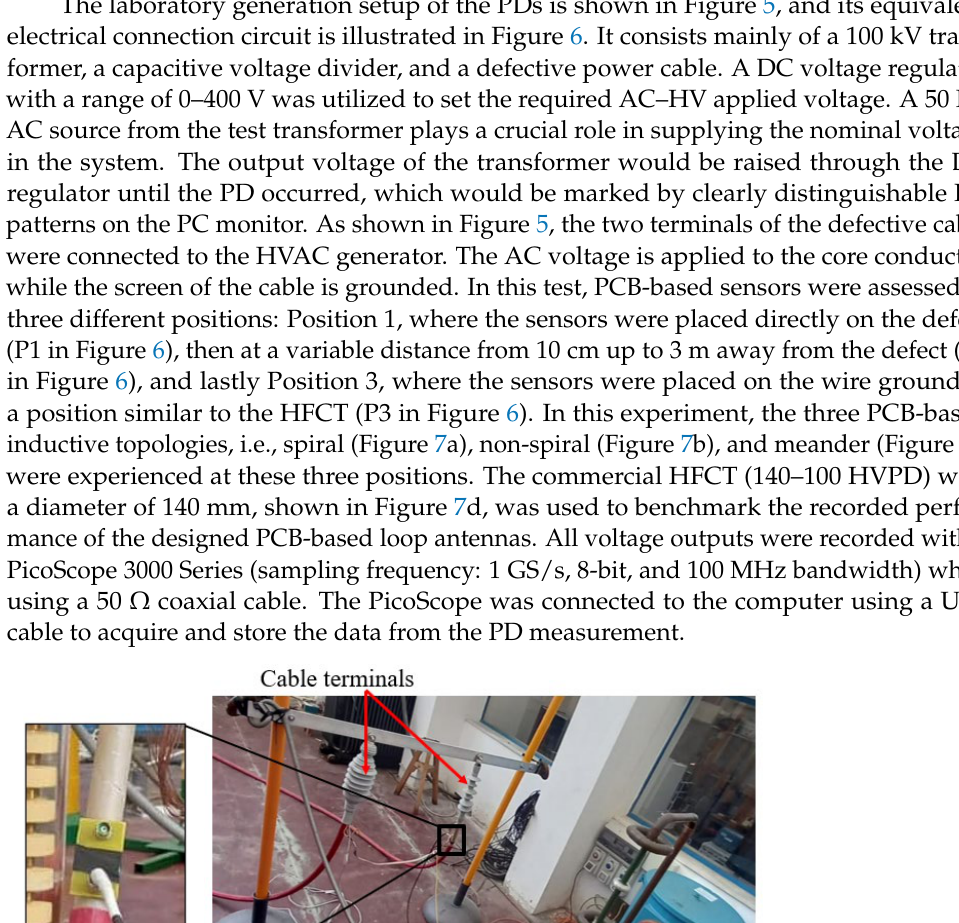
Figure 6. Equivalent electrical connection circuit of the setup. ( a ) ( d ) Figure 7. Inductive sensors tested in the experiment setup: ( a ) spiral, ( b ) non-spiral, ( c ) meander, and ( d ) the HFCT. 4. PD Measurement: Results and Discussion At first, a PD measurement under AC voltage was carried out to characterize the type of discharge associated with the faulty cable. This experiment was performed with a gradually increasing voltage to determine the value of the PD Inception Voltage (PDIV)